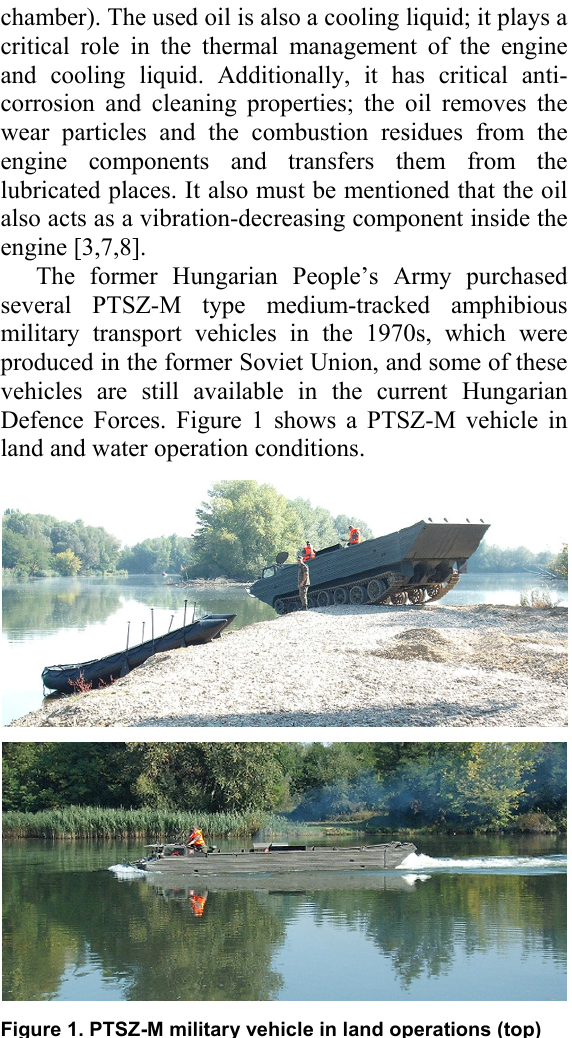
Figure 1. PTSZ-M military vehicle in land operations (top) and in water operation (bottom) condition (pictures of the